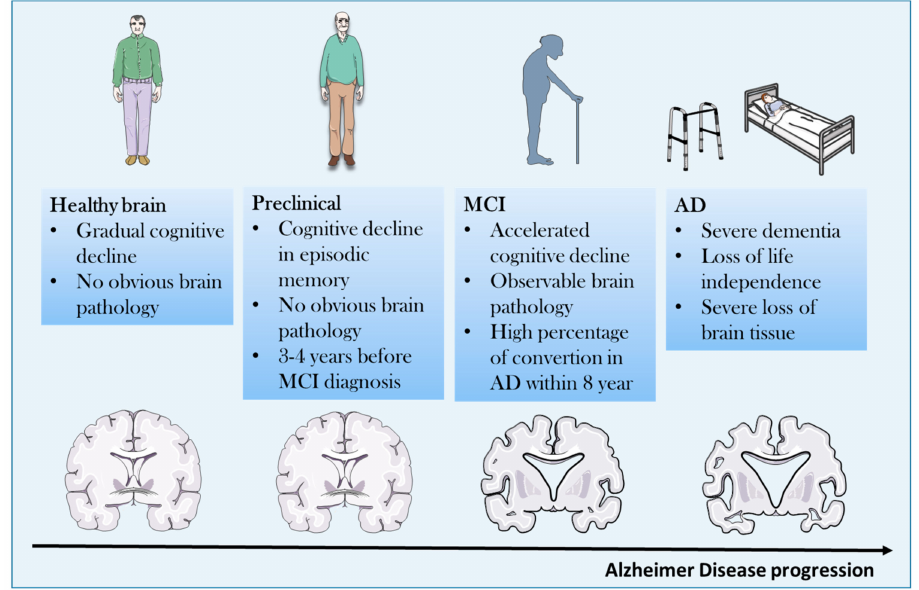
Figure 1. Clinical course of Alzheimer (cid:48) s disease (AD) from asymptomatic to symptomatic stage. MCI: Mild Cognitive